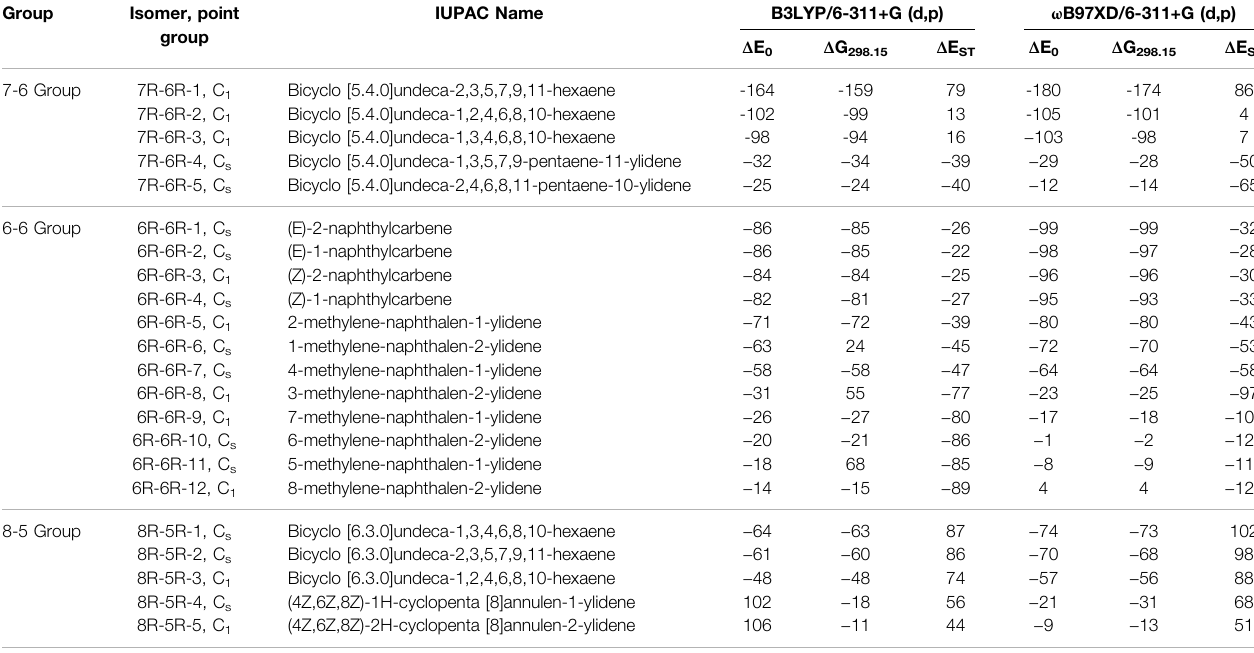
TABLE 1 | ZPVE-Corrected Relative Energies( Δ E 0 ; in kJ mol − 1 ), Gibbs Free Energies ( Δ G 298.15 ; in kJ mol − 1 ), and Singlet-Triplet Energy Gaps ( Δ E ST ; in kJ mol − 1 ) oflow-lying C 11 H 8 carbene/cyclic allene isomers calculated at Different Levels. Group Isomer, point group